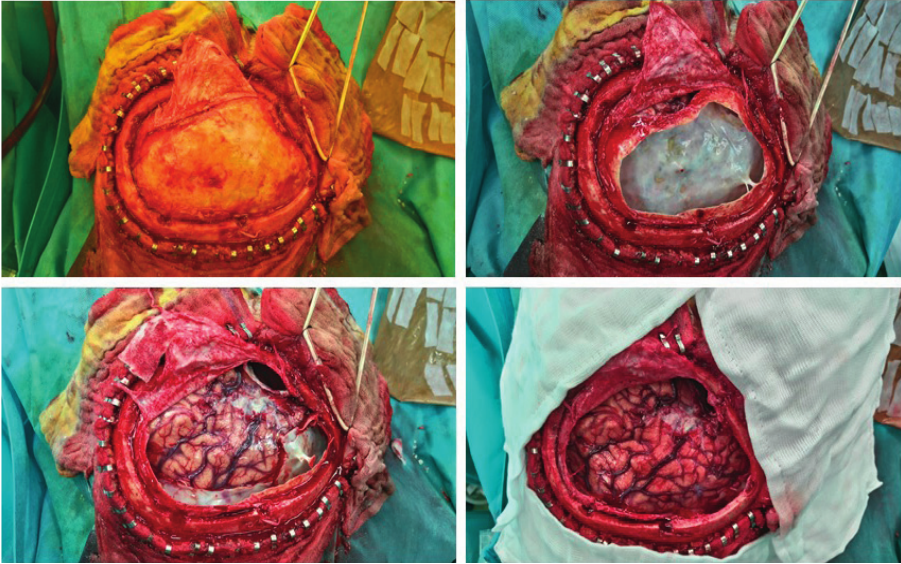
Fig. 2. Intraoperative picures before and after removal of calcified chronic subdural